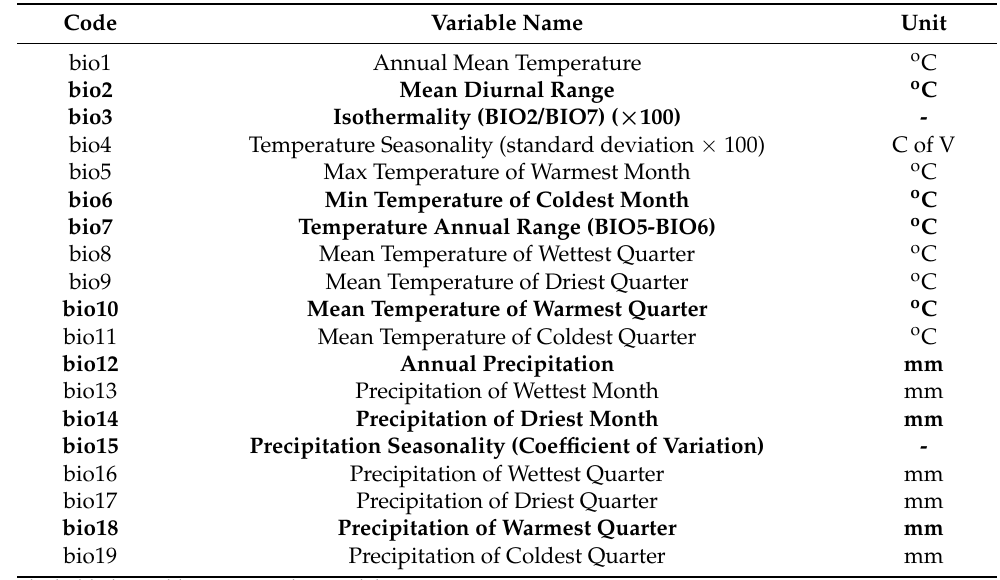
Table 1. Climate variables used for modeling climatic